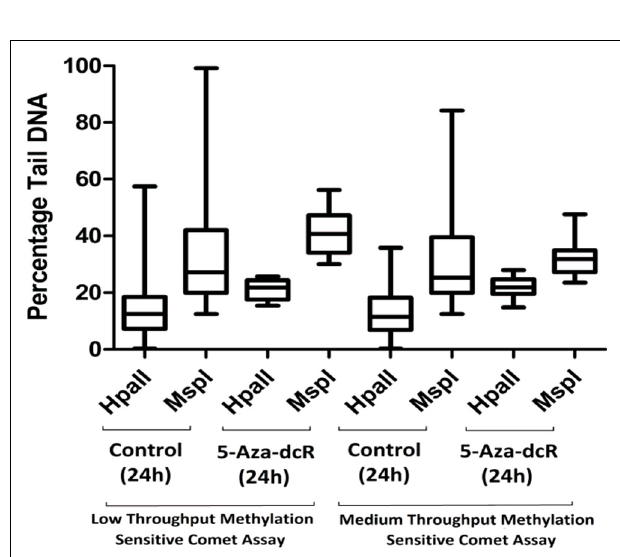
FIGURE 2 | DNA methylation of HepG2 cells treated with 5-Aza-dcR. Comparison between global CpG methylation of cells in culture under normal conditions and treated with the demethylation agent 5-Aza-dcR using the two methylation sensitive comet assays and the CEA. All experiments were at least performed in triplicate with two independent repeats.